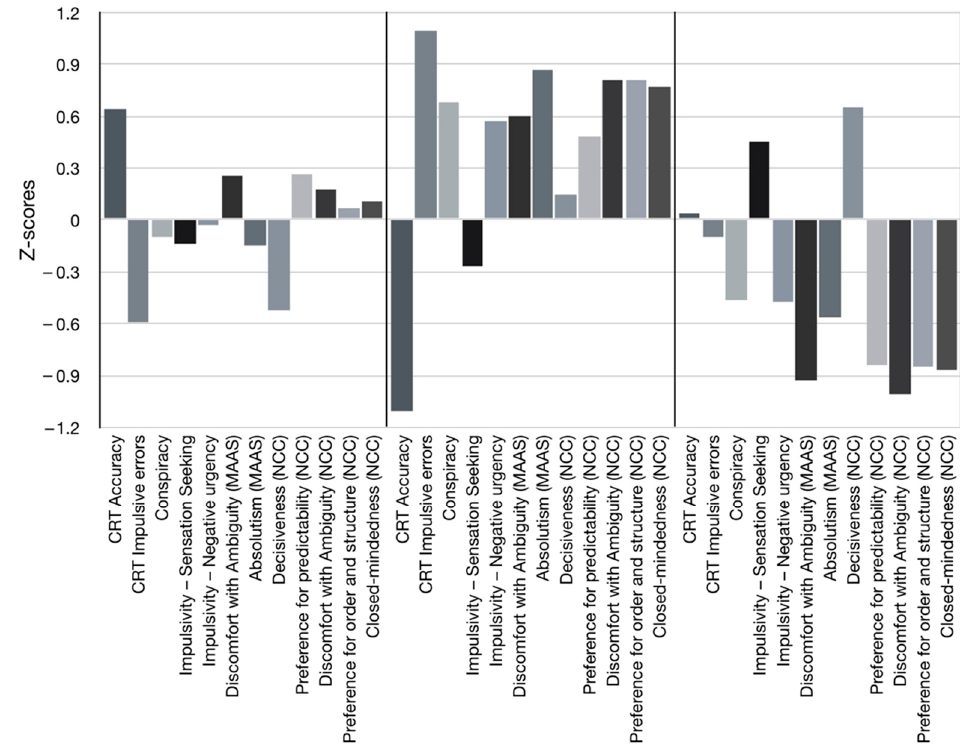
Figure 1. Three-cluster solution profiles, based on the following input measures: (1) CRT accuracy; (2) CRT impulsive errors; (3) conspiracy; (4) impulsivity—sensation seeking; (5) impulsivity—negative urgency; (6) discomfort with ambiguity (MAAS); (7) absolutism (MAAS); (8) decisiveness (NCC); (9) preference for predictability (NCC); (10) discomfort with ambiguity (NCC); (11) preference for order and structure (NCC); (12) closed-mindedness (NCC).